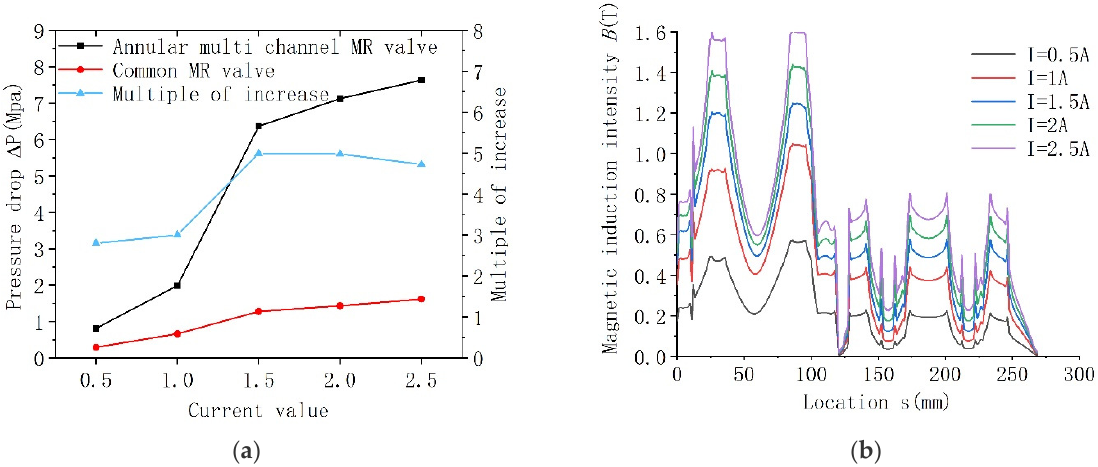
Figure 8. ( a ) Influence of current size on magnetic flux density of the valve; ( b ) influence of current size on valve pressure drop performance.